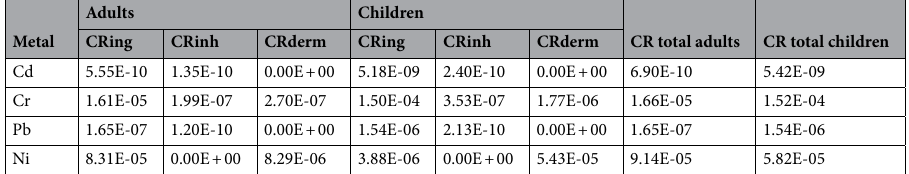
Table 7. CR values from agricultural soils containing metals for adults and children.